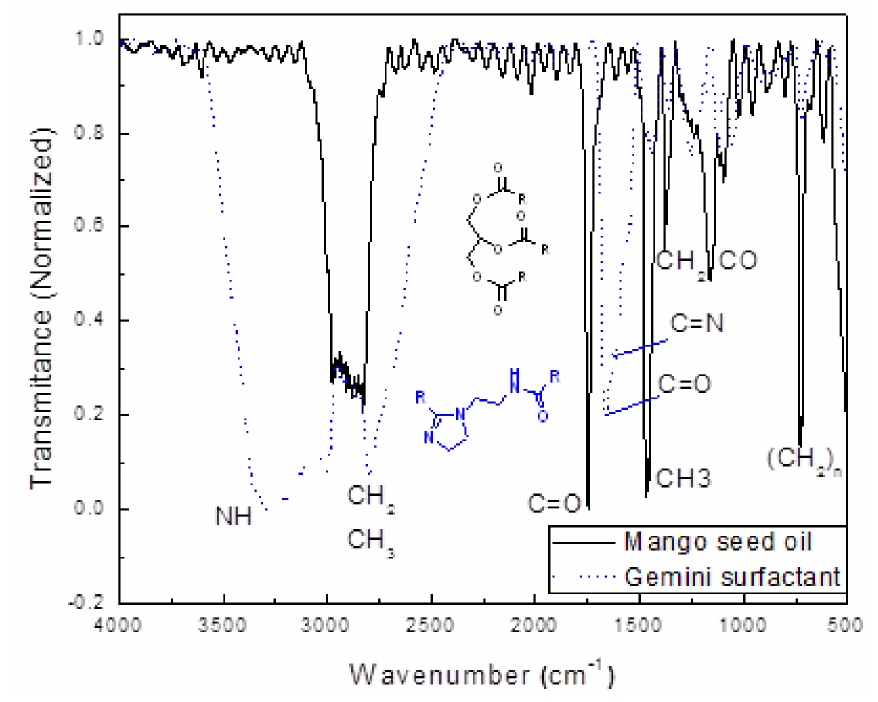
Figure 2. Infrared spectra of mango seed oil and Gemini